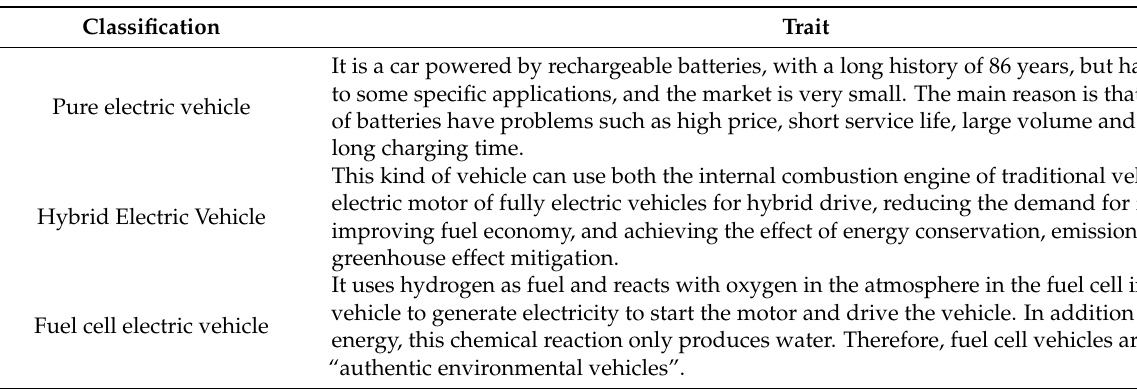
Table 1. Classification of new energy vehicles.